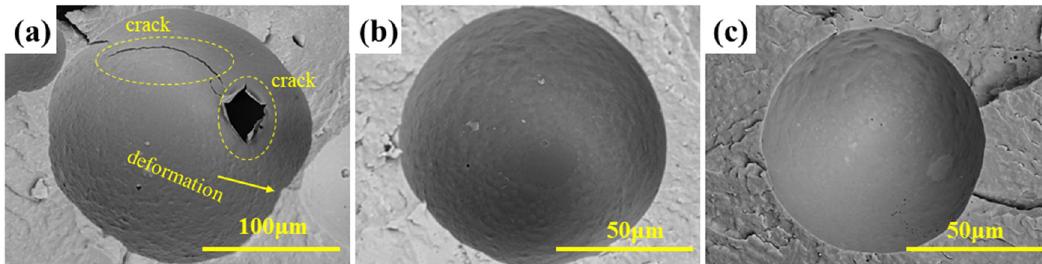
Figure A2: Cell microscopic morphology of ( a ) pure PA6, ( b ) PA6 - ZeMac 0.5, and ( c ) PA6 - TGIC